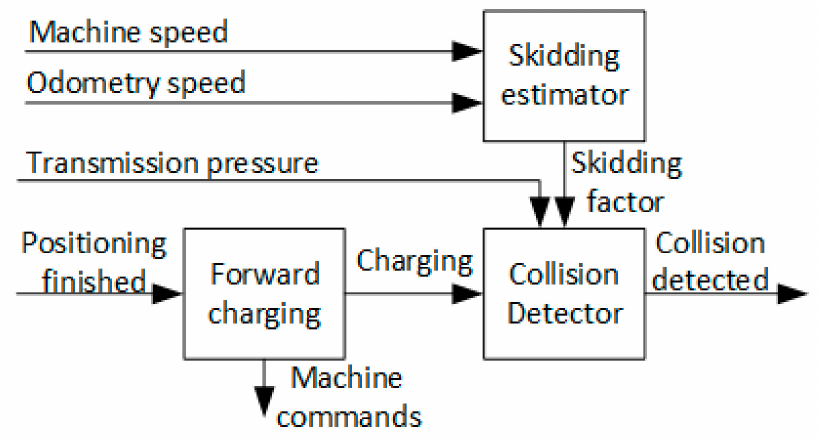
Figure 15. Charging block diagram. The machine is driven forward while a collision detection routine analyzes the machine’s transmission pressure and an estimated skidding